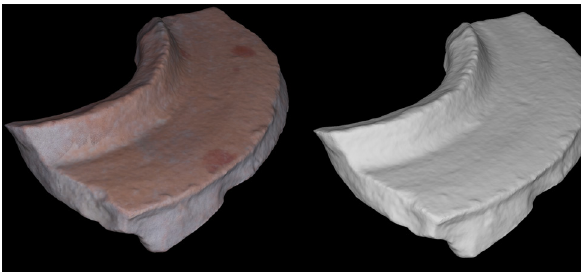
Figure 11: 3D model with texture color ( left ) and without texture information ( right )